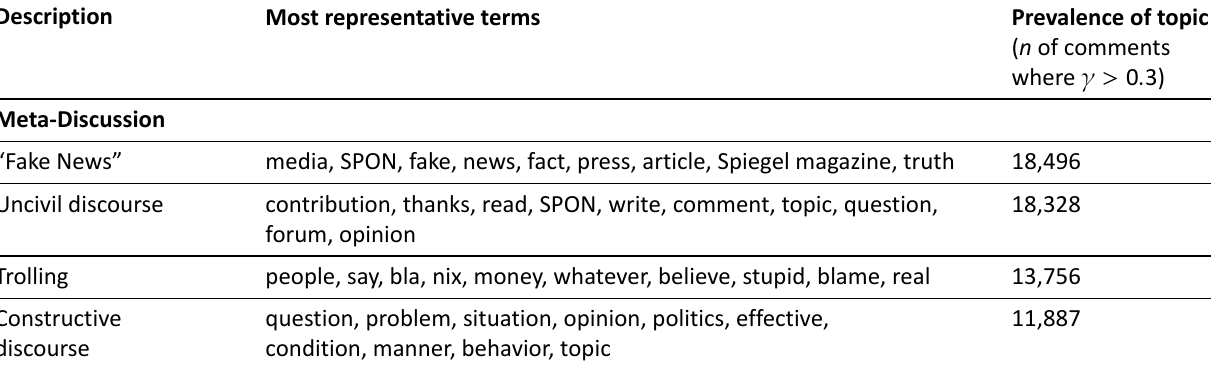
Table 1. (Cont.) Description of user comment